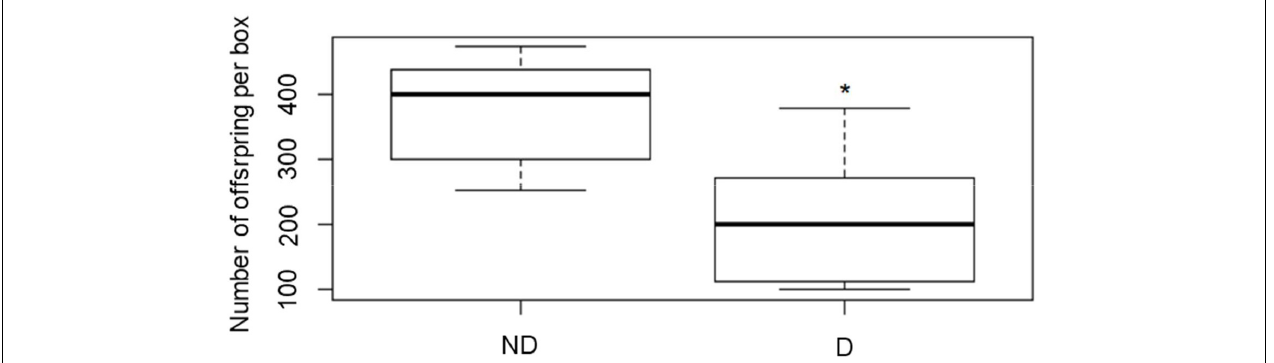
FIGURE 7 | Number of offspring recorded in insects after they were kept for 8 days at 60 (no desiccation, ND) or 14 (desiccation, D) % RH, before being returned to optimal rearing conditions for 1 week, followed by 30 days of monitoring of the development of the offspring. The boxplots present median (horizontal line), 25th and 75 percentiles (box), and the standard deviation (error bars). * Indicates significant difference shown by a one-way ANOVA ( P <